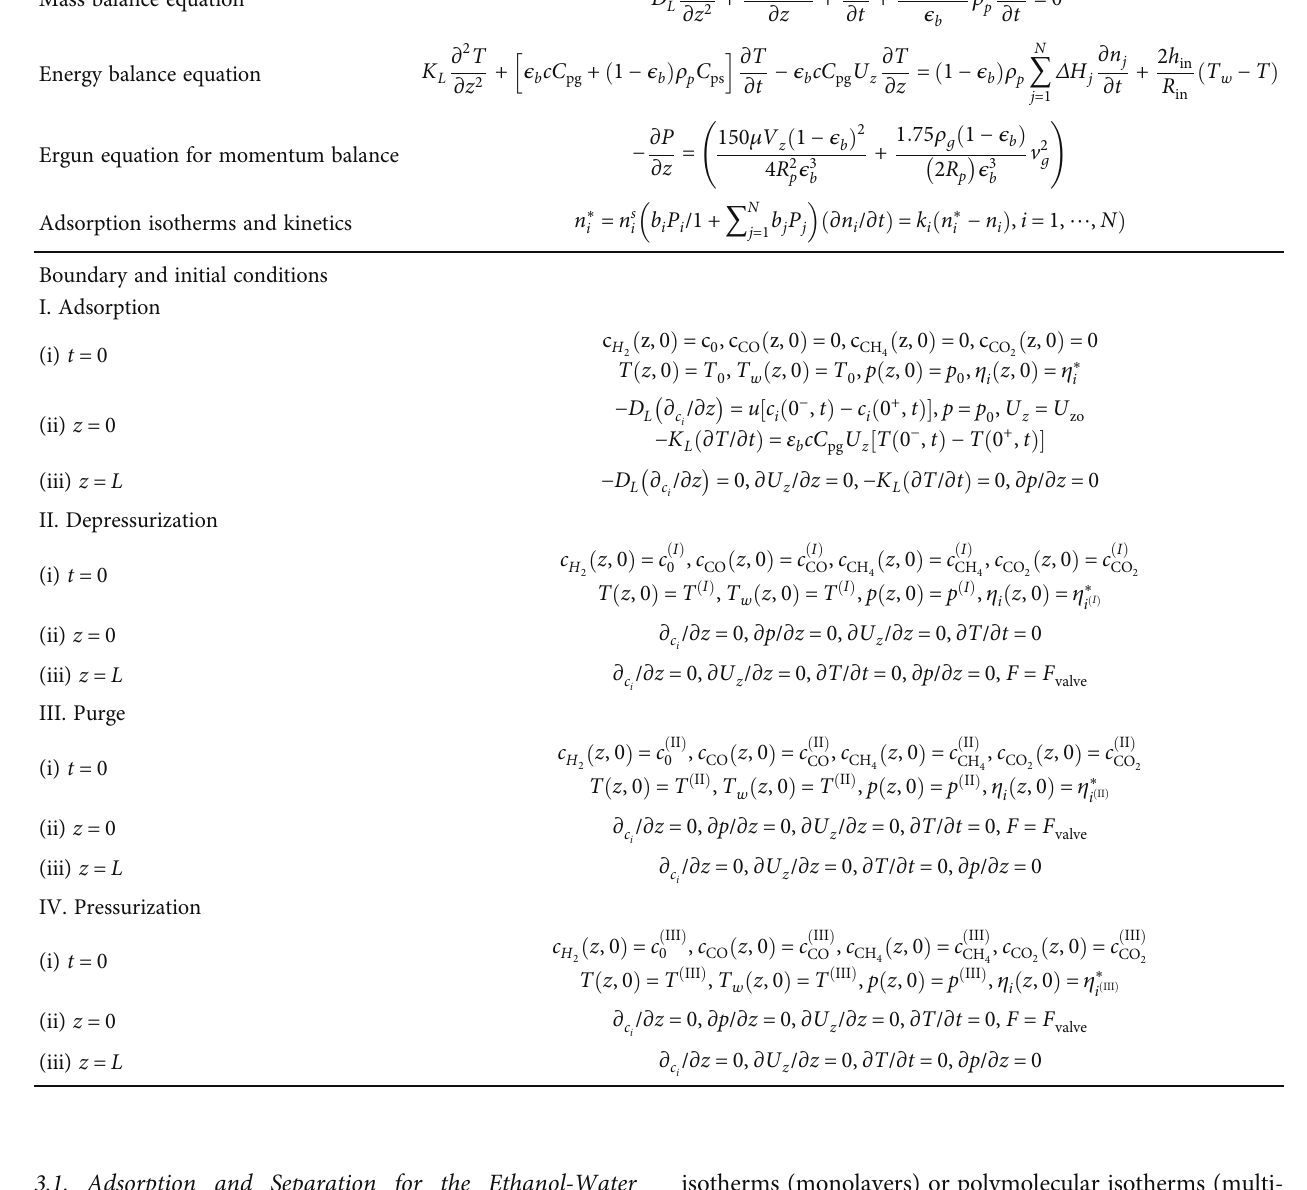
Table 11: Governing equations and simpli fi cations for production and puri fi cation of biohydrogen. Mass balance